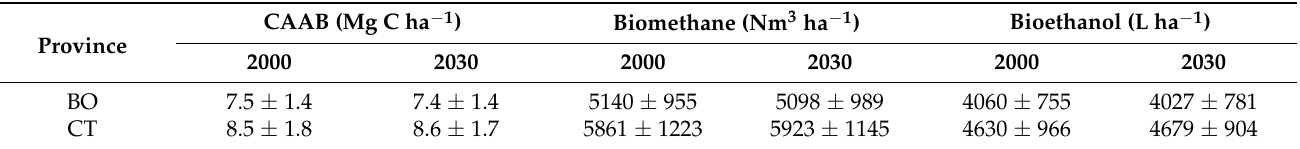
Table 2. Average values and standard deviation of (i) carbon accumulation in the aerial biomass (CAAB; Mg C ha − 1 ), (ii) biomethane (Nm 3 ha − 1 ), and (iii) bioethanol (L ha − 1 ) yields simulated for the baseline (2000) and 2030 in the marginal areas of Bologna and Catania